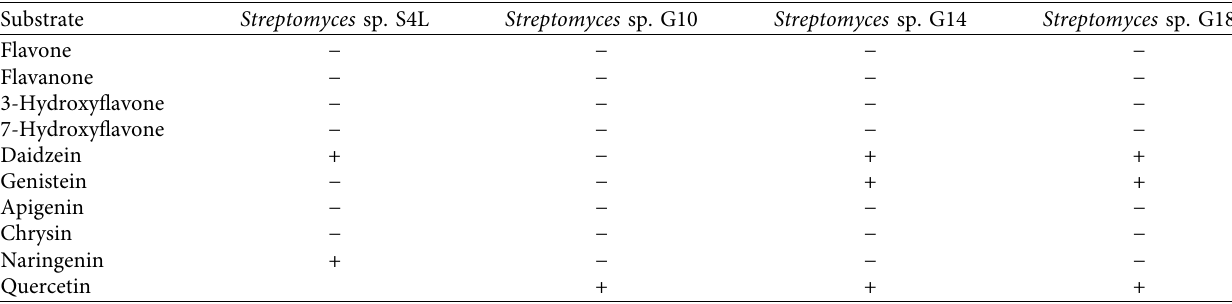
Table 1: Screening of flavone, isoflavone, and flavanone against Streptomyces species for biotransformation of diverse substrate molecules. Analysis was based on the HPLC chromatogram of unknown peaks, where (+) means biotransformation positive results and means no biotransformation based on the unknown peak in the HPLC